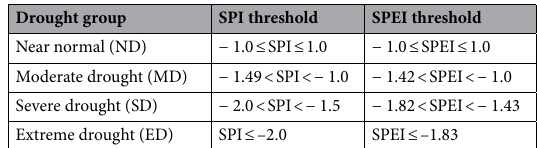
Table 1. SPI and SPEI drought category classification 111